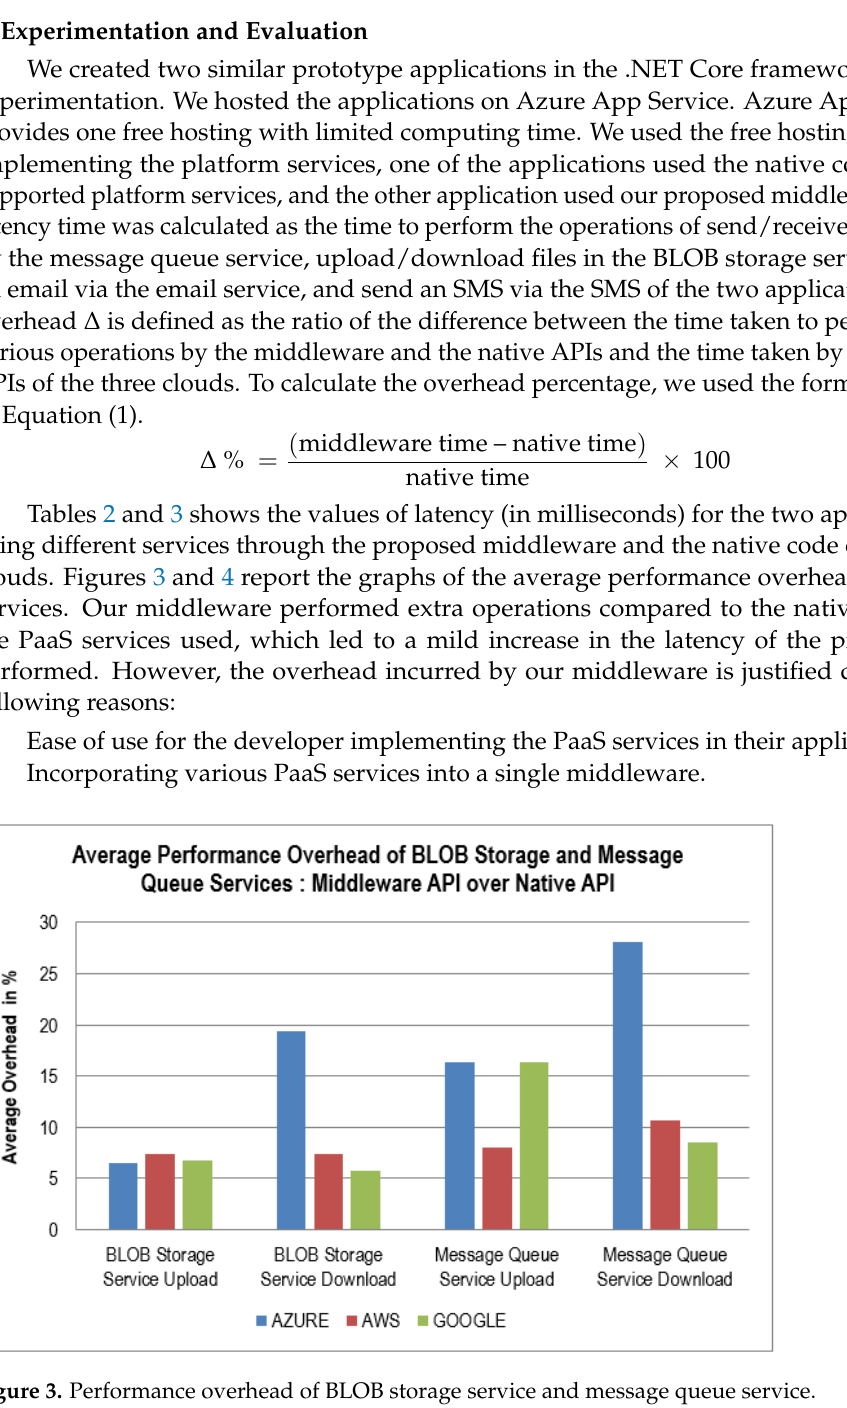
Figure 4. Performance overheads of email service and SMS service. The performance overhead graph (Figure 3) shows the average differences in the times taken in uploading/downloading 100, 500, and 1000 files (1MB each) to/from the BLOB storage and sending/reading 100, 500, and 1000 messages to/from the message queue on all the three clouds using native code versus using our proposed middleware. These average overhead percentages in both the implemented services are minimal except